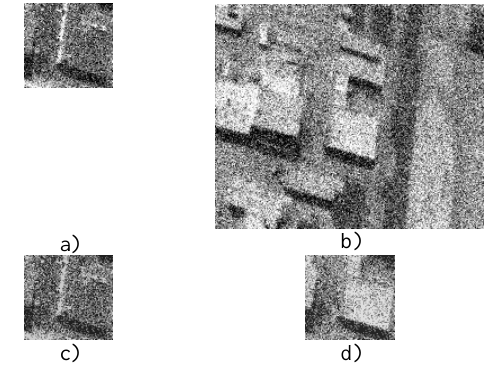
Figure 3. Example 2: a) etalon TV; b) test IR; c) segmented TV fragment; d) corresponding segmented IR fragment.